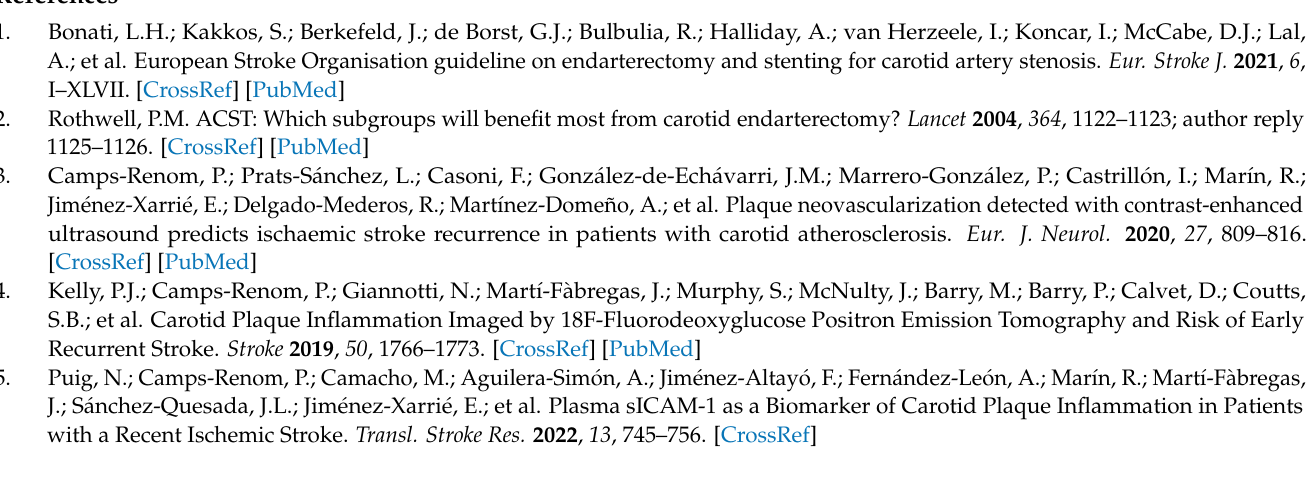
patients; Table S2: Serum MDA levels and antioxidant capacity; Table S3: Correlation between the proportion of LDL( − ) and oxLDL with other lipid-related parameters; Table S4: Clinical variables and lipid parameters in patients with predominantly hypoechoic or hyperechoic plaque; Table S5: Clinical variables and lipid parameters in patients with diffuse or non-diffuse intraplaque neovascularization. Figure S1: Nitrite levels in serum; Figure S2: Parameters of HDL